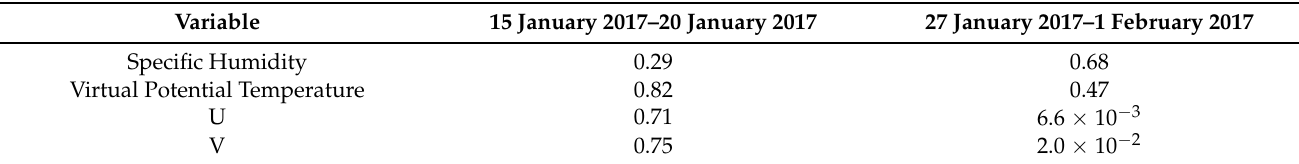
Table 2. Table of p -values from conducting Welch’s two-sample t -test to compare the MLR and ANN